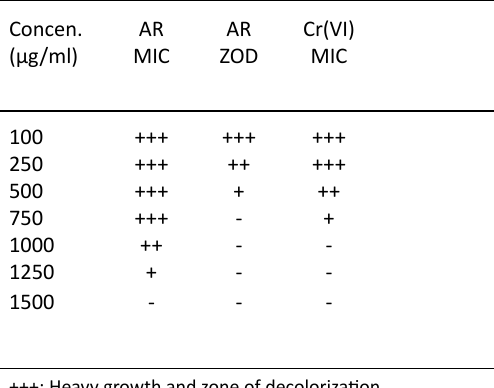
Table 1A. MIC of AR and Cr(VI) individually on growth and ZOD in TSA media Concen.